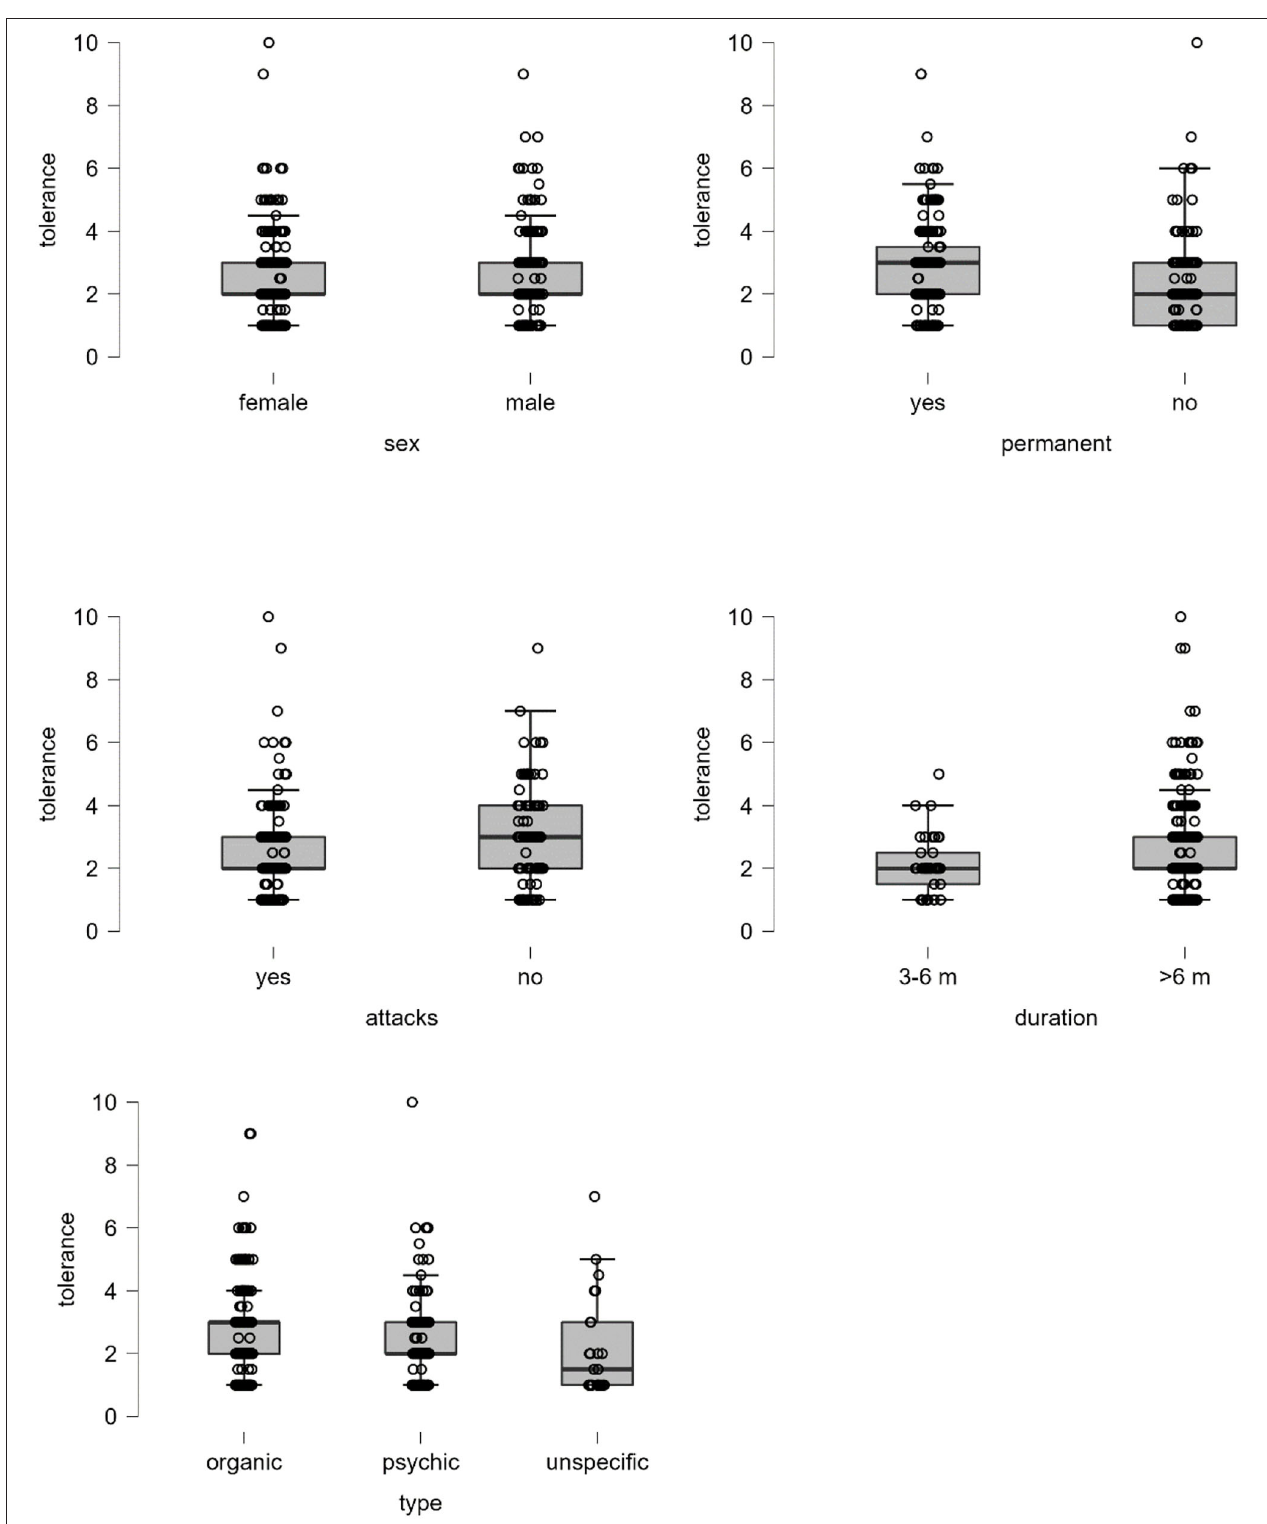
FIGURE 3 | Boxplots for tolerance. Test statistics for Mann–Whitney U -test: sex p = 0.632, permanent p < 0.001, attack p < 0.001, and duration p = 0.026. Test statistic for Kruskal–Wallis test: type p = 0.001, unspecific – psychic p = 0.075, unspecific – organic p = 0.002, psychic – organic p = 0.016.